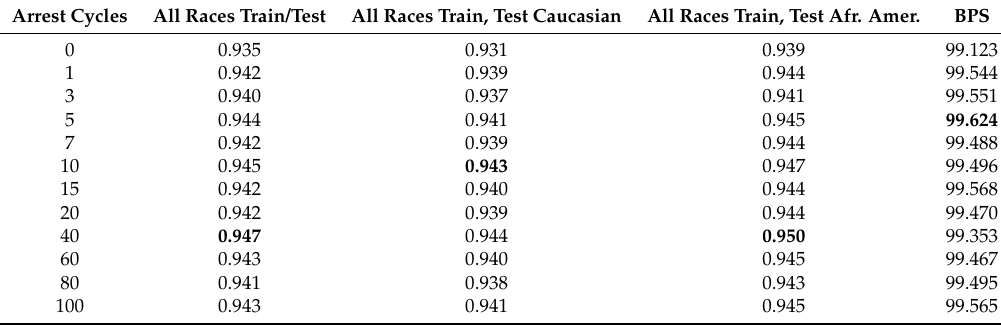
Table 6. Average true-positive